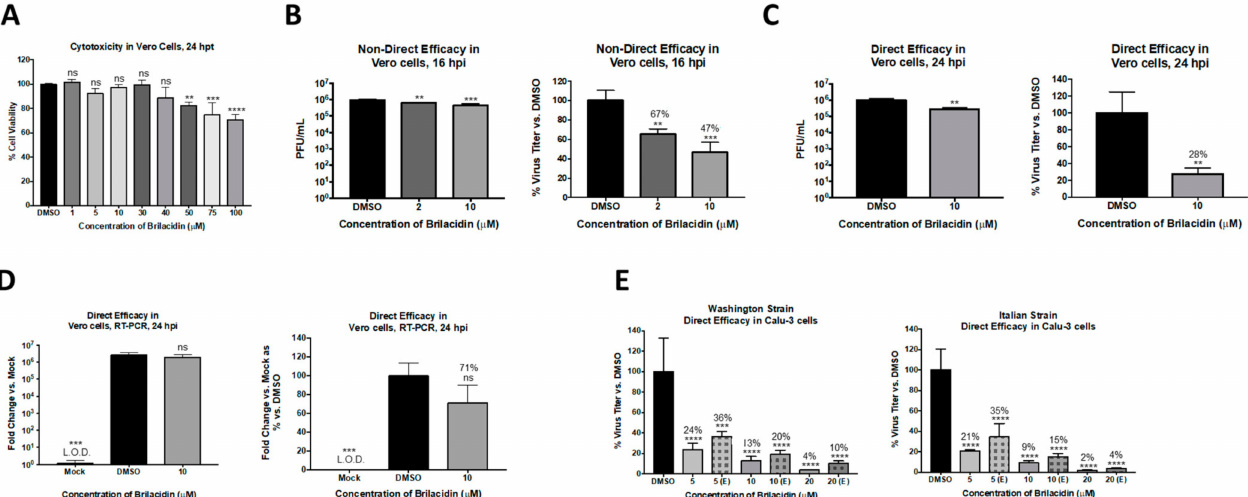
Figure 2. Brilacidin displays statistically significant inhibitory efficacy against Severe Acute Respiratory Syndrome Coron- avirus 2 (SARS-CoV-2) in two cell types and against two different strains. ( A ) Vero cells were treated at various concentrations of brilacidin, and cell viability was measured versus the dimethyl sulfoxide (DMSO) control at 24 h post-treatment (hpt) as described in Materials and Methods. ( B ) Vero cells were pretreated for 2 h with 2 or 10 µ M brilacidin, infected with SARS-CoV-2 nondirectly at multiplicity of infection (MOI) 0.1 for 1 h, and post-treated with media containing brilacidin as described in Materials and Methods. At 16 h postinfection (hpi), viral supernatants were evaluated by plaque assay as described in Materials and Methods. Vero cells were pretreated for 2 h with 10 µ M brilacidin. SARS-CoV-2 was diluted to MOI 0.1 in culture media containing brilacidin and incubated for 1 h. Viral inoculum containing inhibitor was added to cells for 1 h for a direct infection and post-treated with media containing brilacidin as described in Materials and Methods. At 24 hpi, ( C) viral supernatants were evaluated by plaque assay, and ( D ) total RNA was extracted from intracellular lysates and viral RNA was quantified by RT-PCR as described in Materials and Methods. ( E ) Calu-3 cells were pretreated for 2 h with varying concentrations of brilacidin (5, 10, or 20 µ M) or media only (indicated as [E, entry]). SARS-CoV-2 was diluted to MOI 0.1 in culture media containing brilacidin (5, 10, or 20 µ M) and incubated for 1 h. Brilacidin-treated viral inoculum was added to cells for 1 h for a direct infection and replaced with inhibitor containing media or media only (indicated as [E, entry]) as described in Materials and Methods. At 24 hpi, viral supernatants were evaluated by plaque assay as described in Materials and Methods. Graphs are representative of one independent experiment performed in technical triplicates ( n =